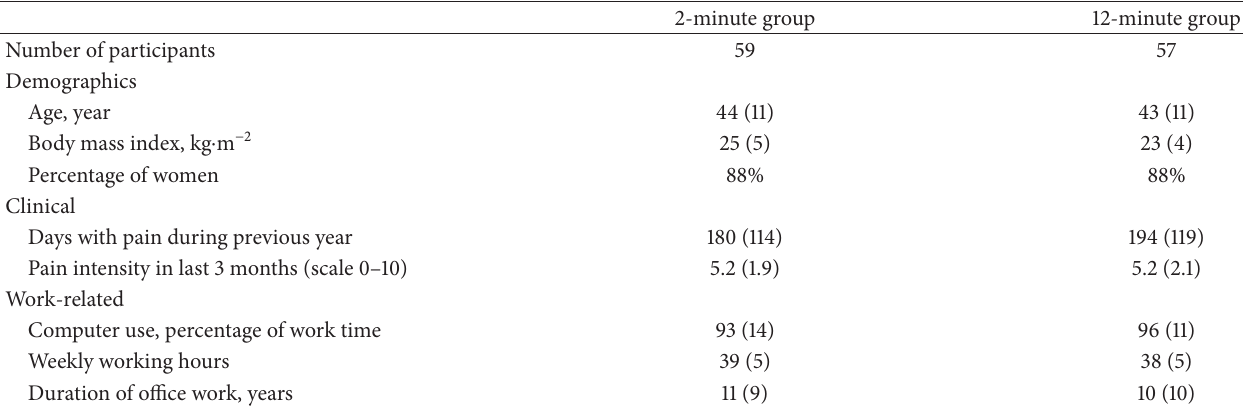
Table 1: Demographics, clinical and work-related characteristics of the participants in the 2 and 12min groups who replied to the follow-up questionnaire used in the present analyses. Values are reported as mean (SD) or percentage of